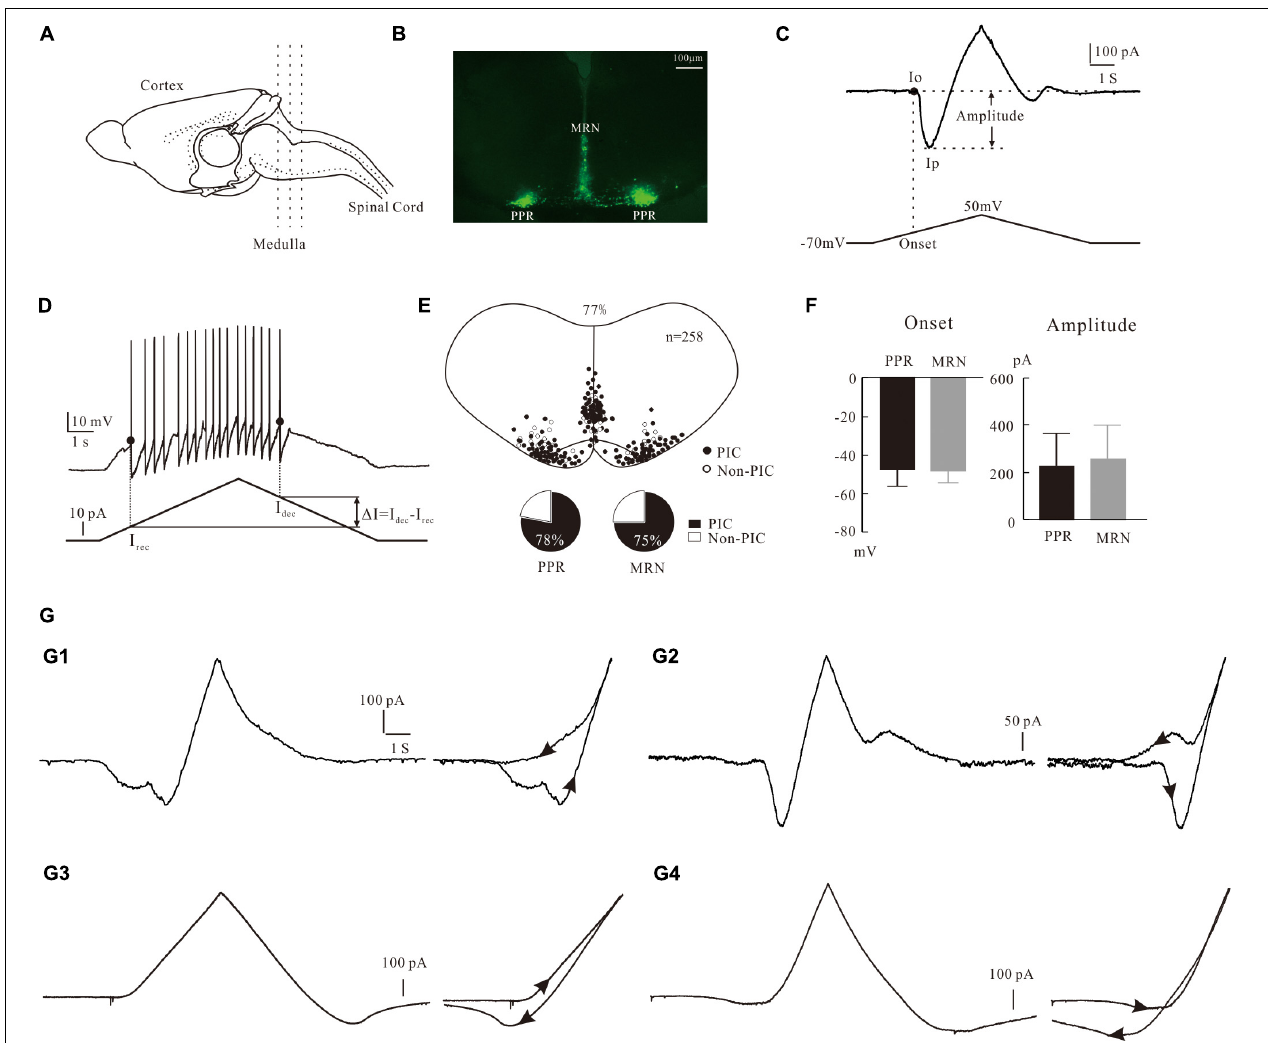
FIGURE 1 | Characterization of PICs in 5-HT neurons. (A) The transverse slices were collected from the medulla indicated by dash lines. (B) One slice cut from the sections shows the EYFP + serotonin (5-HT) neurons with enhanced yellow fluorescent proteins in parapyramidal region (PPR) and midline raphe nuclei (MRN) areas. (C) Measurement of biophysical parameters of PICs by the voltage bi-ramp from − 70 to 50 mV. (D) Measurement of biophysical parameters (recruitment currents, decruitment currents, and difference (cid:49) I) from repetitive firing induced by current bi-ramp with a duration of 10 s, peak of 60–80 pA, and holding current of zero pA. (E) Distribution of 5-HT neurons with PICs in medulla (top). Proportions of PICs (solid) and Non-PICs (open) recorded from PPR and MRN 5-HT neurons (bottom). (F) Statistic results of the onset and amplitude of PICs in PPR ( n = 107) and MRN ( n = 91). Error bars show SD, unpaired t -test. (G) Four patterns of PICs in 5-HT neurons of medulla. (G1) a-PIC only with counterclockwise hysteresis. (G2) a-PIC > d-PIC with counterclockwise hysteresis of PICs. (G3) d-PIC only with clockwise hysteresis. (G4) d-PIC > a-PIC with clockwise hysteresis of PICs.